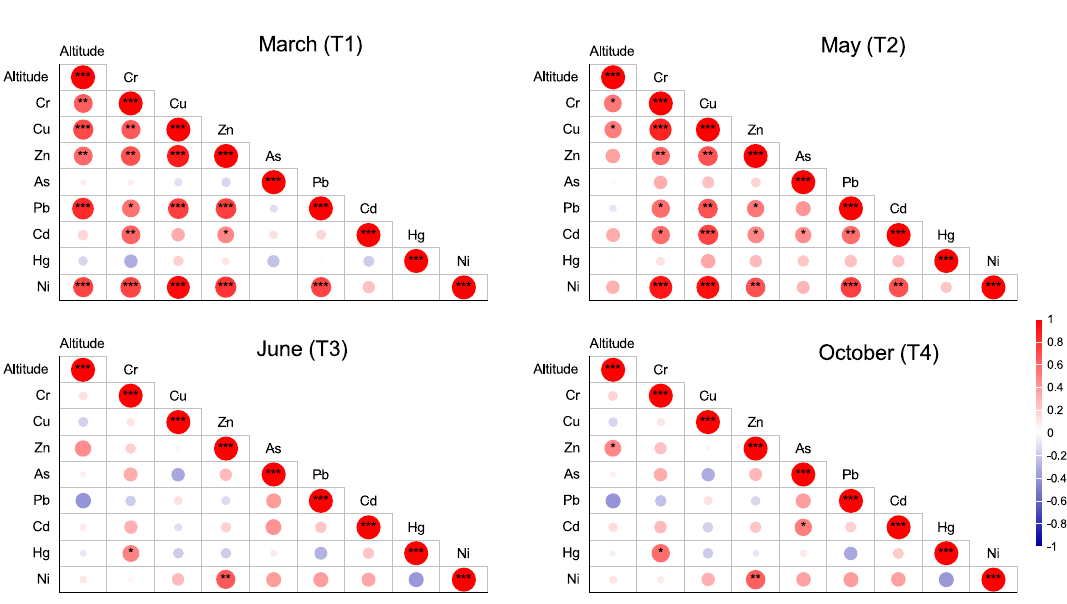
Figure 4. Pearson product-moment correlation inter-metals and between heavy metals and altitude from Olt River 2018